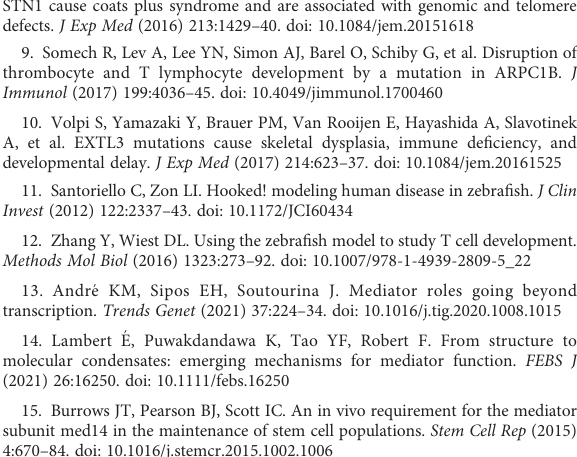
SUPPLEMENTARY FIGURE 5 Assessment of Med14 V769A/ f hematopoietic progenitor function by competitive bone marrow transplantation. 100x10 5 allotype marked wild type (CD45.1) and Med14 V769A/ f mutant (CD45.2) lineage negative hematopoietic stem and progenitor cells (HSPC) were combined and transferred together into CD45.1 recipients that had been treated with 1100 rads (2x550r, 4h apart) 24h earlier. Recipient mice were placed on antibiotic-treated water (polymyxin B sulfate and neomycin) for 3 weeks and analyzed 6 weeks after transplantation. Single cell suspensions of thymus (A) and spleen (B, C) were stained with CD45.1 and CD45.2 antibodies to distinguish the genotypes of transferred HSPC and with the indicated lineage markers. Bromodeoxyuridine (BrdU) labeling was conducted by staining permeabilized cells after 24h of labeling. Gate frequencies were calculated and depicted as bar graphs of the mean +/- standard deviation. Statistical signi fi cance were determined using the t- test. P-values are indicated on the graphs. NS, not signi fi cant. SUPPLEMENTARY FIGURE 6 Molecular modeling of the wild type and variant mouse MED14 proteins. Two views of wild type (orange) and V769A mutant (green) mouse MED14 are depicted. The right half of each panel shows a zoomed in view of aa 769withnearbyresiduesontheopposinghelixthatarecapableofmaking contacts withtheAor V769.Thetoppanelshows wildtypemouseMED14 V769 from known PDB structure 6W1S chain I, residues 643 to 890. The bottom panel shows the mouse V769A MED14 variant. Hydrophobic contacts are shown with purple lines. SUPPLEMENTARY FIGURE 7 Construction and analysis of the the L1CAM Q497H knockin founder mice. (A) Part of human and mouse L1CAM amino acid sequences were aligned and Q498 in human and Q497 in mouse are highlighted and yellow. (B) The founder mouse was identi fi ed by PCR using tail gDNA and Sanger sequencing using PCR-Rev primer; black arrows indicate silent mutations introduced to prevent from subsequently cutting by Cas9, which do not change the amino acid and the red arrows indicate a G to C change to make Q to H mutation in mouse. (C) In vitro proliferation assays were performed using splenic T cells isolated from wild type littermates (WT) and L1cam Q497H (KI) mice, which were labeled with CFSE, stimulated with 2 m g/ml of plate-bound anti-CD3 and 1 m g/ml of anti-CD28 as indicated. Cell proliferation was determined by CFSE